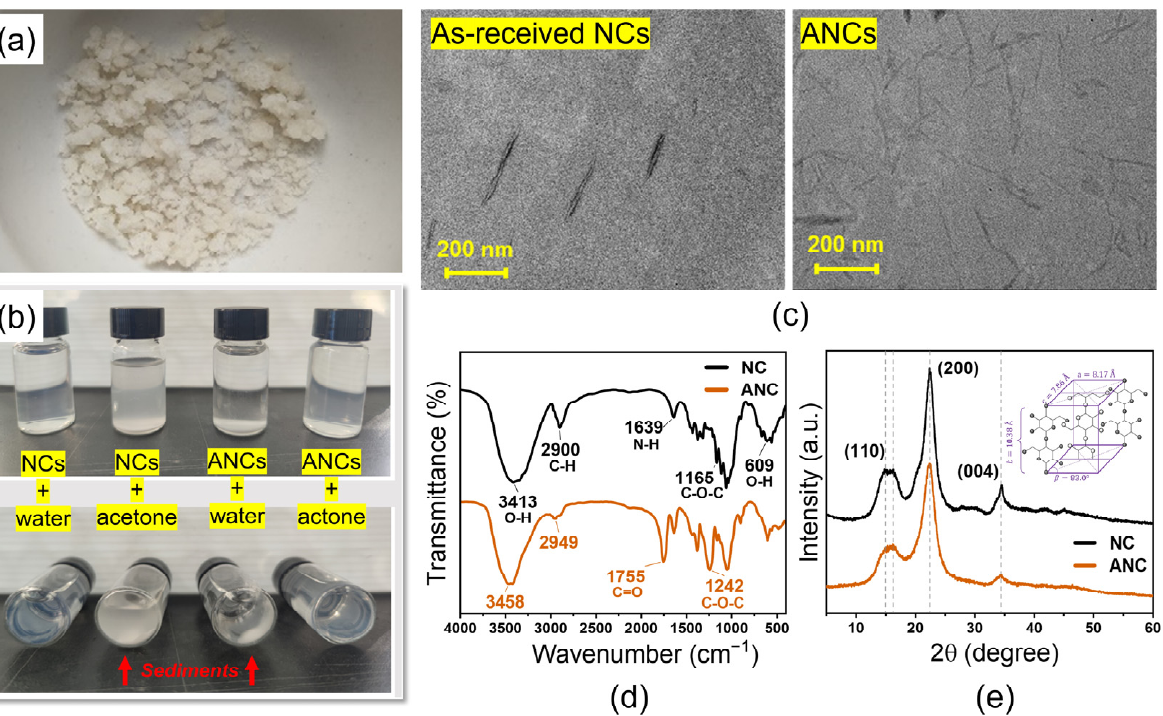
Figure 1. ( a ) Dried acetylated nanocelluloses (ANCs) powder. ( b ) Dispersity comparison of as-re- ceived nanocelluloses (NCs) and synthesized ANCs in water and acetone solutions after 24 h stew- ing. ( c ) TEM photographs of NCs and ANCs. ( d ) FTIR spectra of NCs and ANCs. New bands ap- peared at 1755 and 1242 cm − 1 after acetylation. ( e ) XRD curves of NCs and ANCs accompanied with crystal lattice